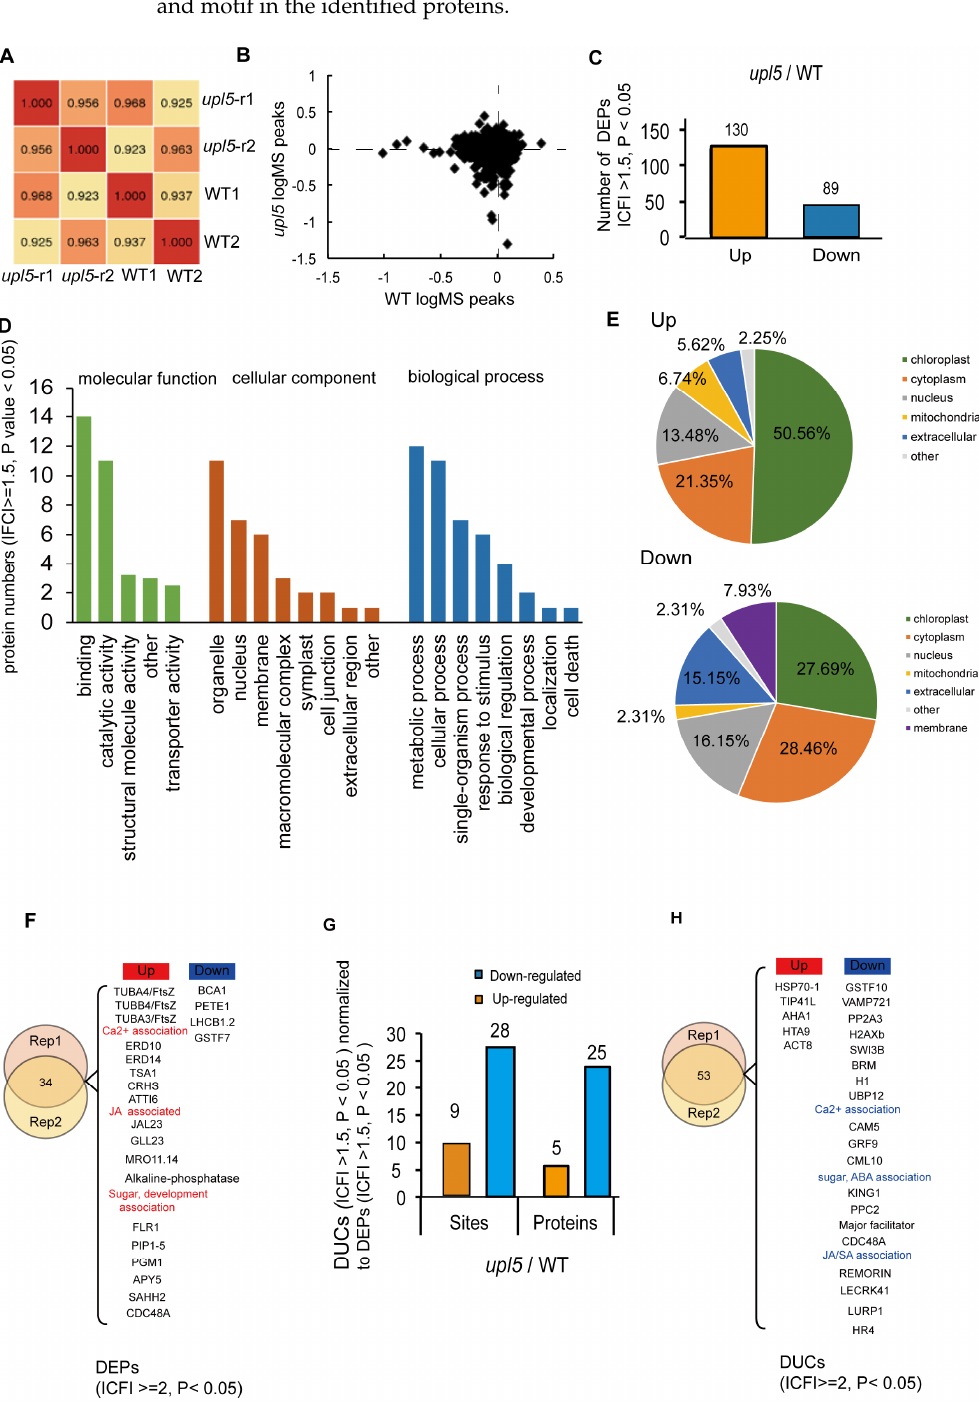
Figure 5. The proteome analysis of the upl5 relative to the wild-type (WT). ( A ) Pearson coefficient analysis of two replicate samples. ( B ) Enrichment peak of proteins in the upl5 relative to the WT. ( C ) Numbers of differentially expressed proteins (DEPs) (Fold changed ≥ 1.5, p value < 0.05) of the upl5 relative to the WT (Left). ( D ) GO analysis of DEPs (Fold changed ≥ 1.5, p value < 0.05) of the upl5 relative to the WT. ( E ) Cellular components of DEPs (Fold changed ≥ 1.5, p value < 0.05) of the upl5